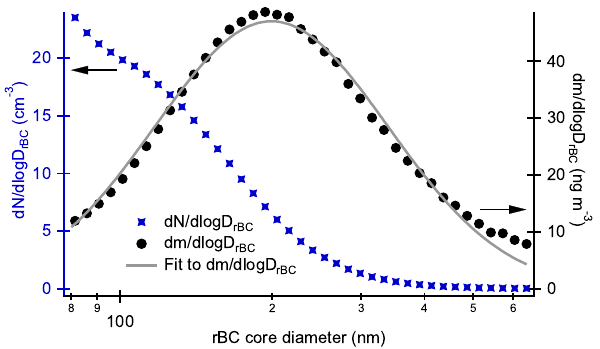
Figure 2. Campaign average rBC mass (black color, right axis) and number (blue color, left axis) size distributions. The solid gray line is a log-normal distribution fitted to the observations (geometric standard deviation is 1.70, geometric mean diameter is 199 nm and total area is 27ngm − 3